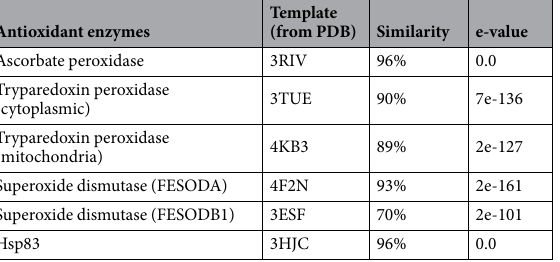
Table1. Template identification of six antioxidant enzymes of L. donovani on the basis of sequence similarity and